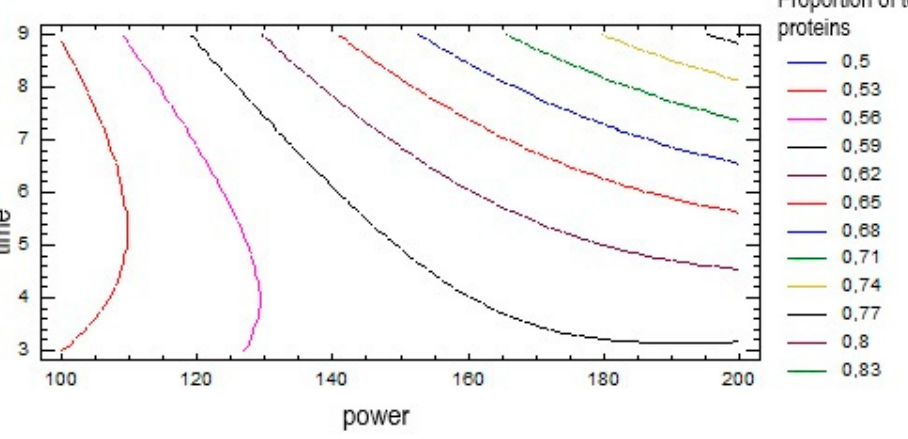
Figure 1. Contour plot of response surfaces for total protein